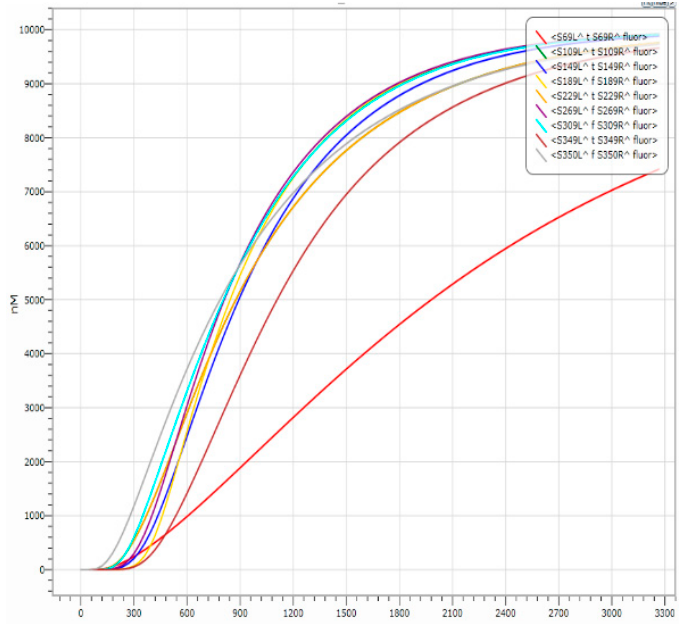
Figure 15. Simulation of 00101101 − 10010110 = 010010111.